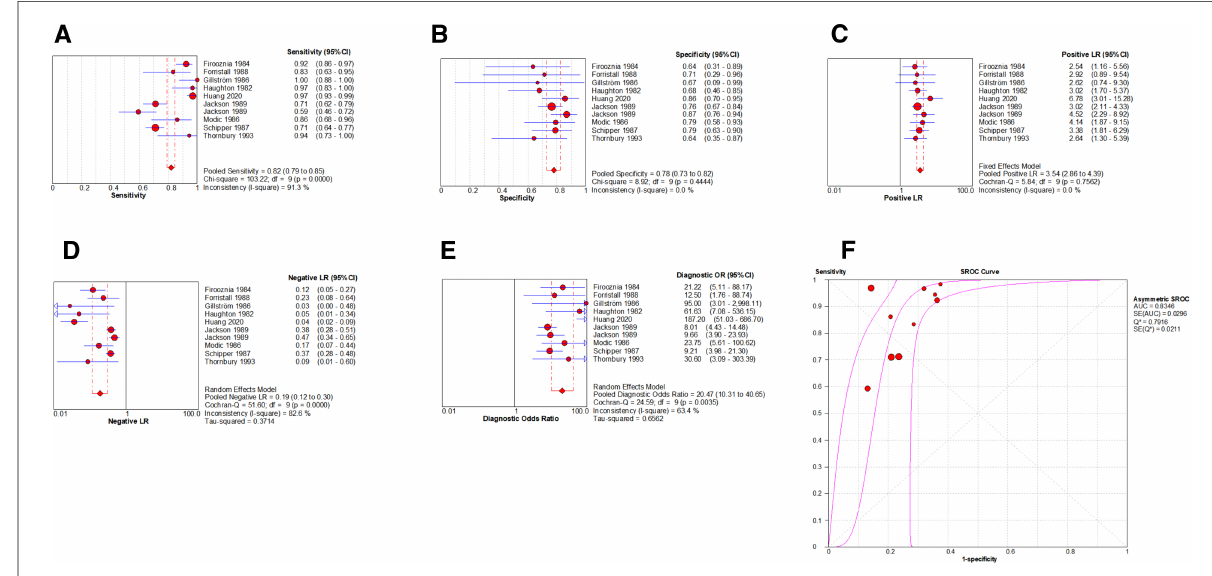
Figure 7 Forest plot of CT for the diagnosis of LDH. The subgraph of ( A – F ) refers to Sen, Spe, +LR, − LR, DOR, AUC and Q*, respecti v